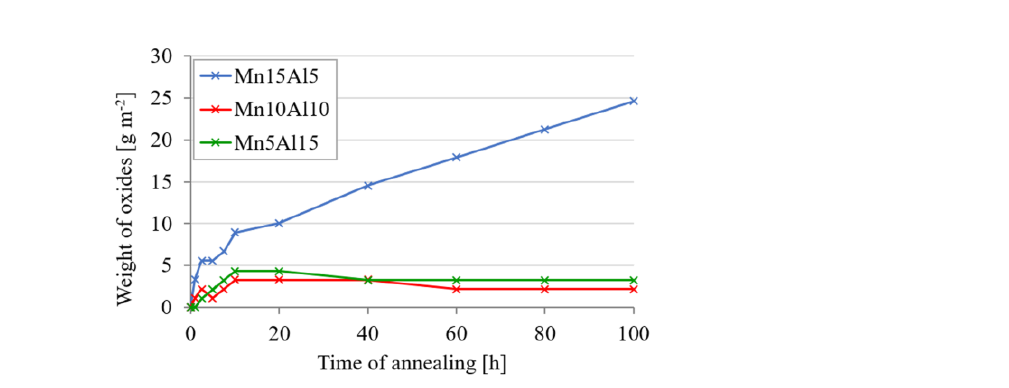
13 of 18 Figure 13. SEM + EDS map of element distribution in the Mn10Al10 MA + SPS compact alloy after 100 h annealing at 800 °C. The high-temperature oxidation at 800 °C was evaluated based on the weight gains of the initially weighted sample with a defined surface. As one can see in Figure 14, the Mn15Al5 alloy showed a sort of parabolic kinetics of oxidation, which is known for rapid weight gain in a matter of minutes and slowing down over time due to the diffusion- driven character of oxygen transport through the developing oxide layer. However, as the annealing prolonged, the oxidation kinetics showed rather a linear mechanism according to the weight gains, suggesting the poor protective behavior of such layer due to, e.g., cracking or formation of pores within the layer. On the other hand, increasing the Al con-